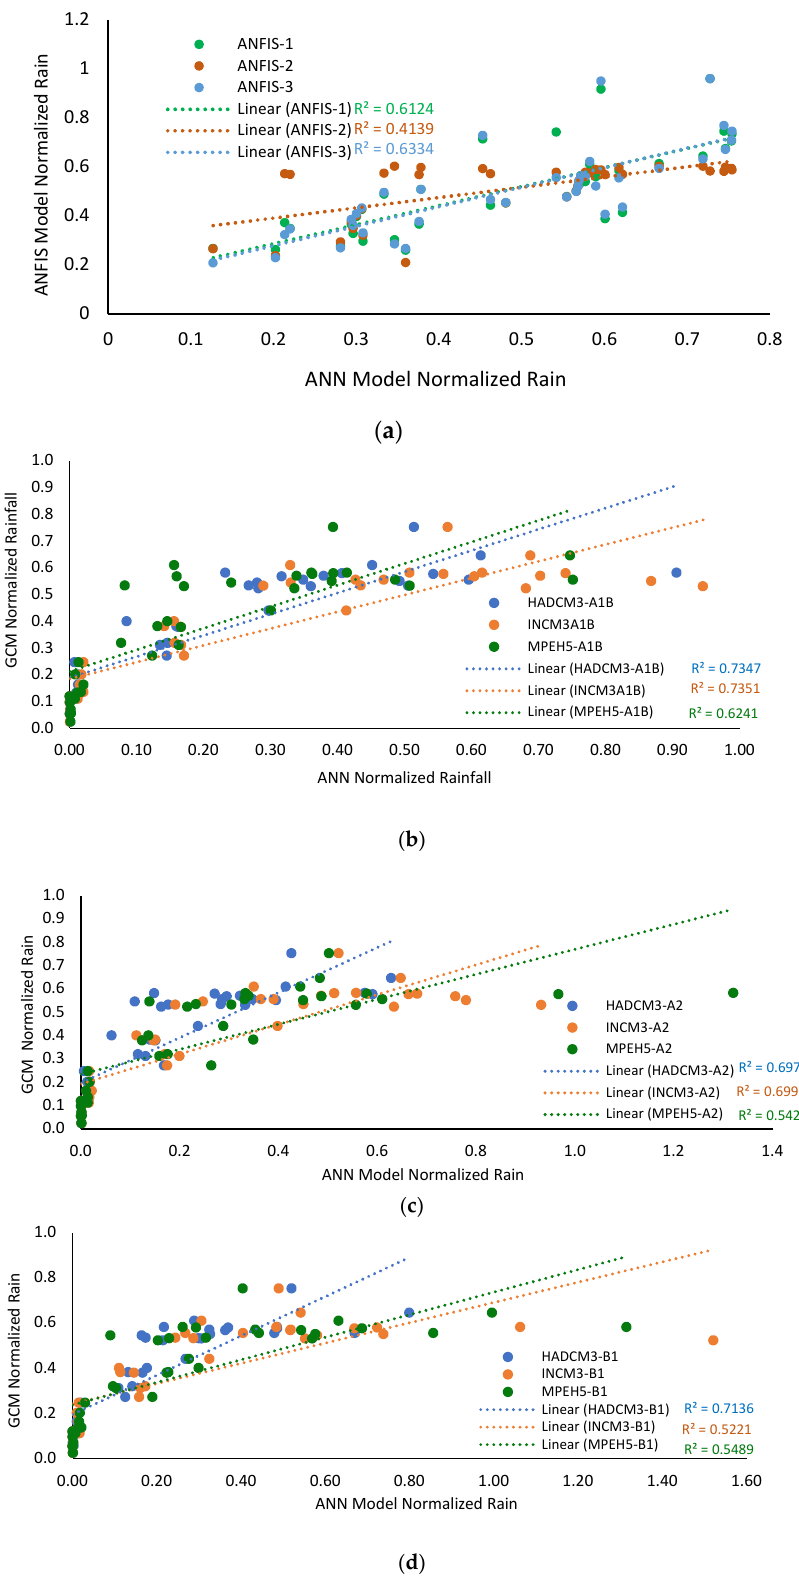
Figure 8. Comparison between ANN and GCM models with various scenarios: ( a ) ANN vs. ANFIS; ( b ) ANN vs. GCM scenario A1B; ( c ) ANN vs. GCM scenario A2; and ( d ) ANN vs. GCM scenario B1.